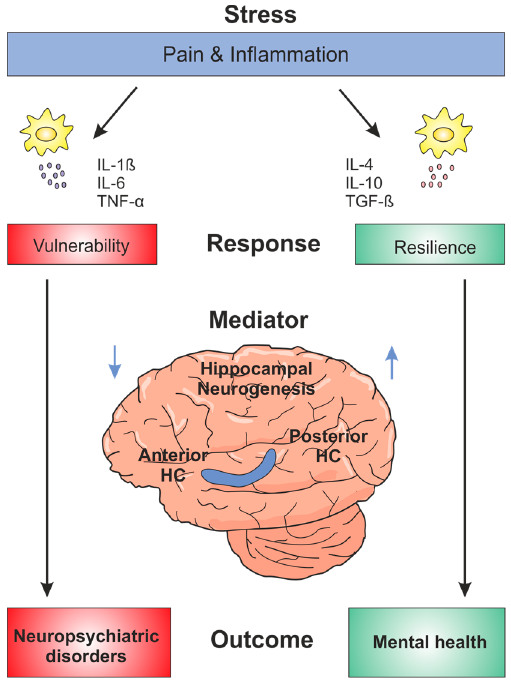
Figure 1. Resilience and vulnerability of the human hippocampus. Hippocampal neurogenesis can be modulated positively and negatively, as indicated with blue arrows. Various factors, such as stress or chronic pain, can negatively regulate neurogenesis and further cause dysregulations of emotional and cognitive functions associated with neuropsychiatric disorders. On the contrary, individuals can employ mechanisms of resilience and maintain homeostasis even under negative conditions. Alternatively, neurogenesis can be modulated in a positive manner and used as a therapeutic means. TNF: tumor necrosis factor; IL: interleukin; TGF: transforming growth factor; HC: hippocampus.